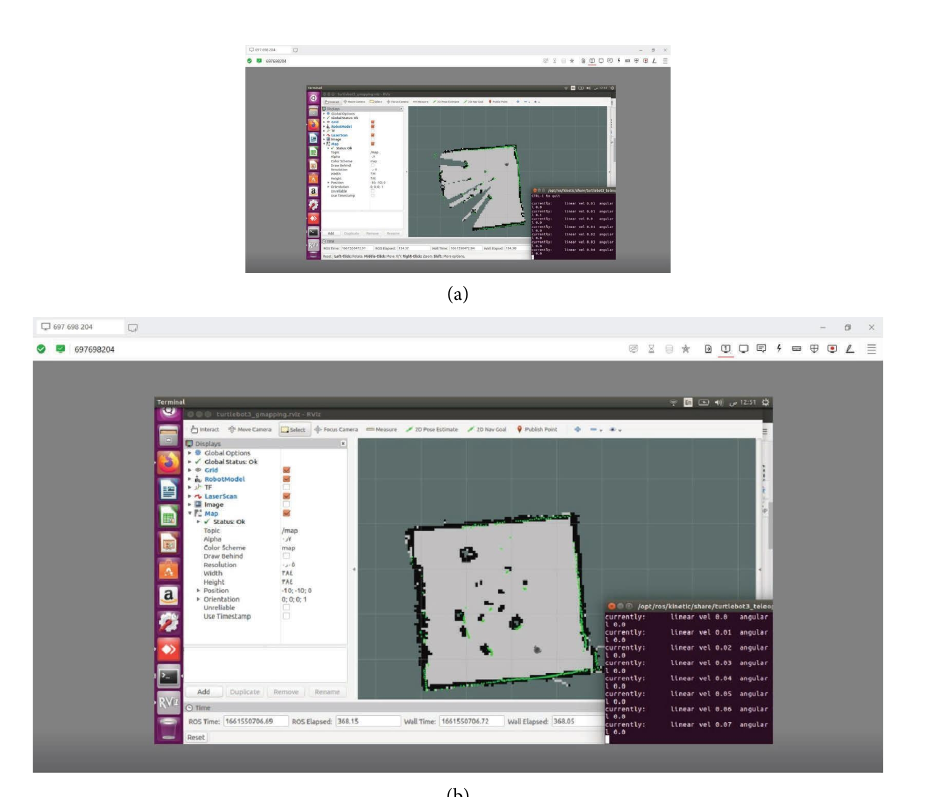
Figure 10: EC2 monitoring.